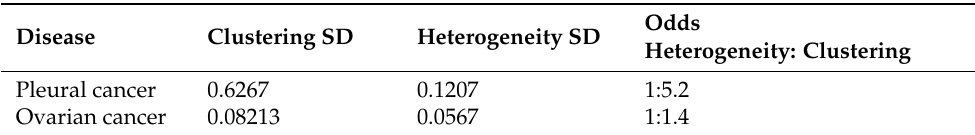
Table 2. Mean of the posterior distribution of the heterogeneity and clustering hyperparameters and the heterogeneity/clustering ratio.